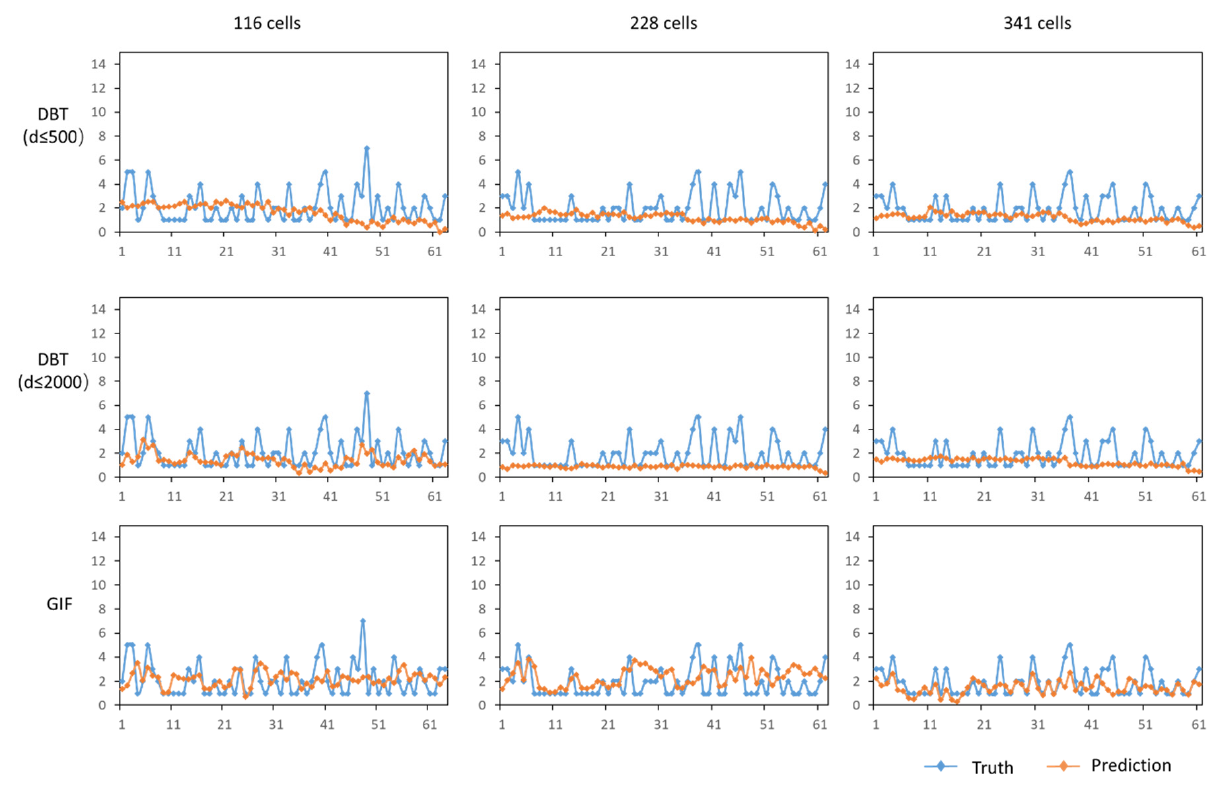
Figure 14. True and predicted values for certain geographic cells at different times. X-axis: time cells (one cell = 6 h). Y-axis: user activity intensity.